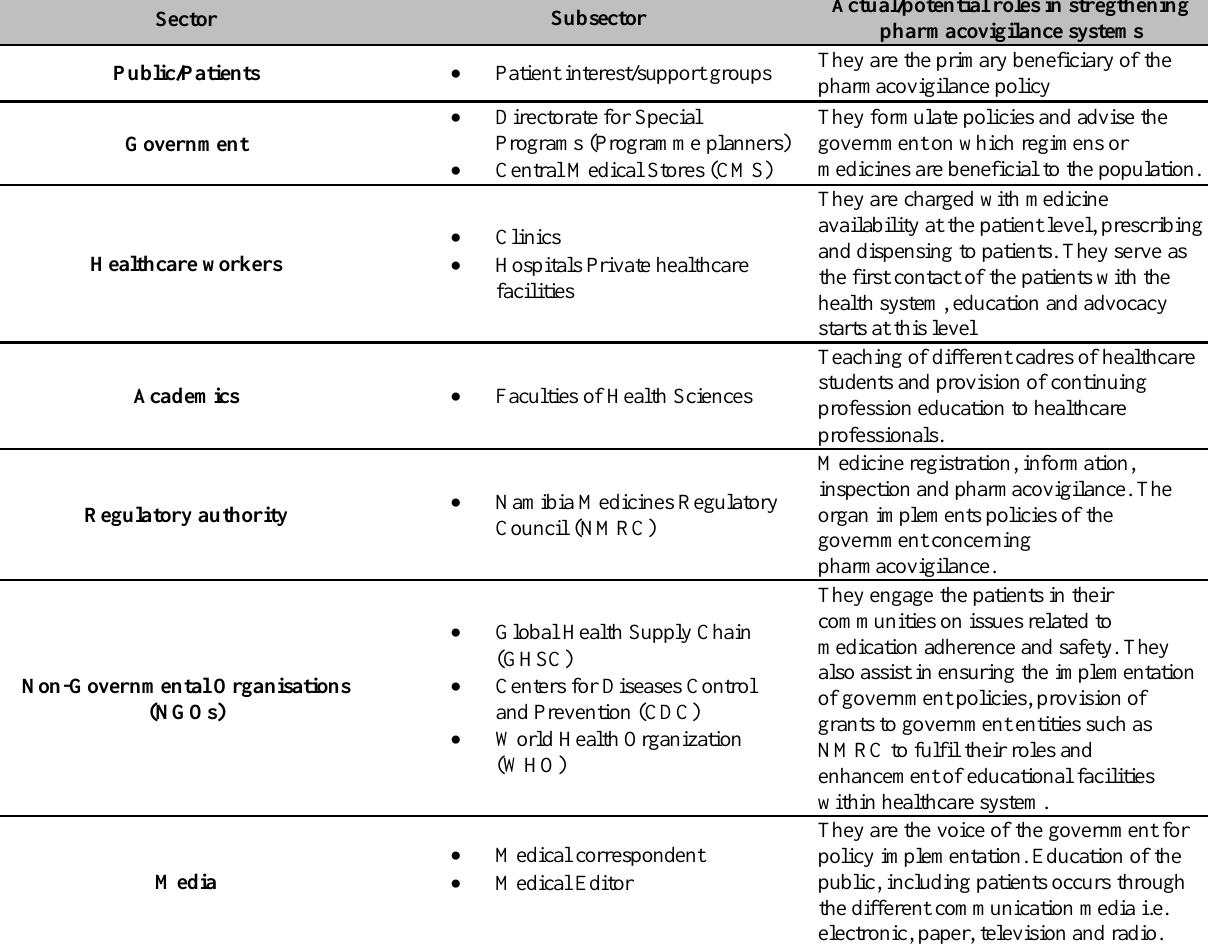
Table 1. Proposed priority stakeholders to be engaged with a justification for each group’s inclusion in the